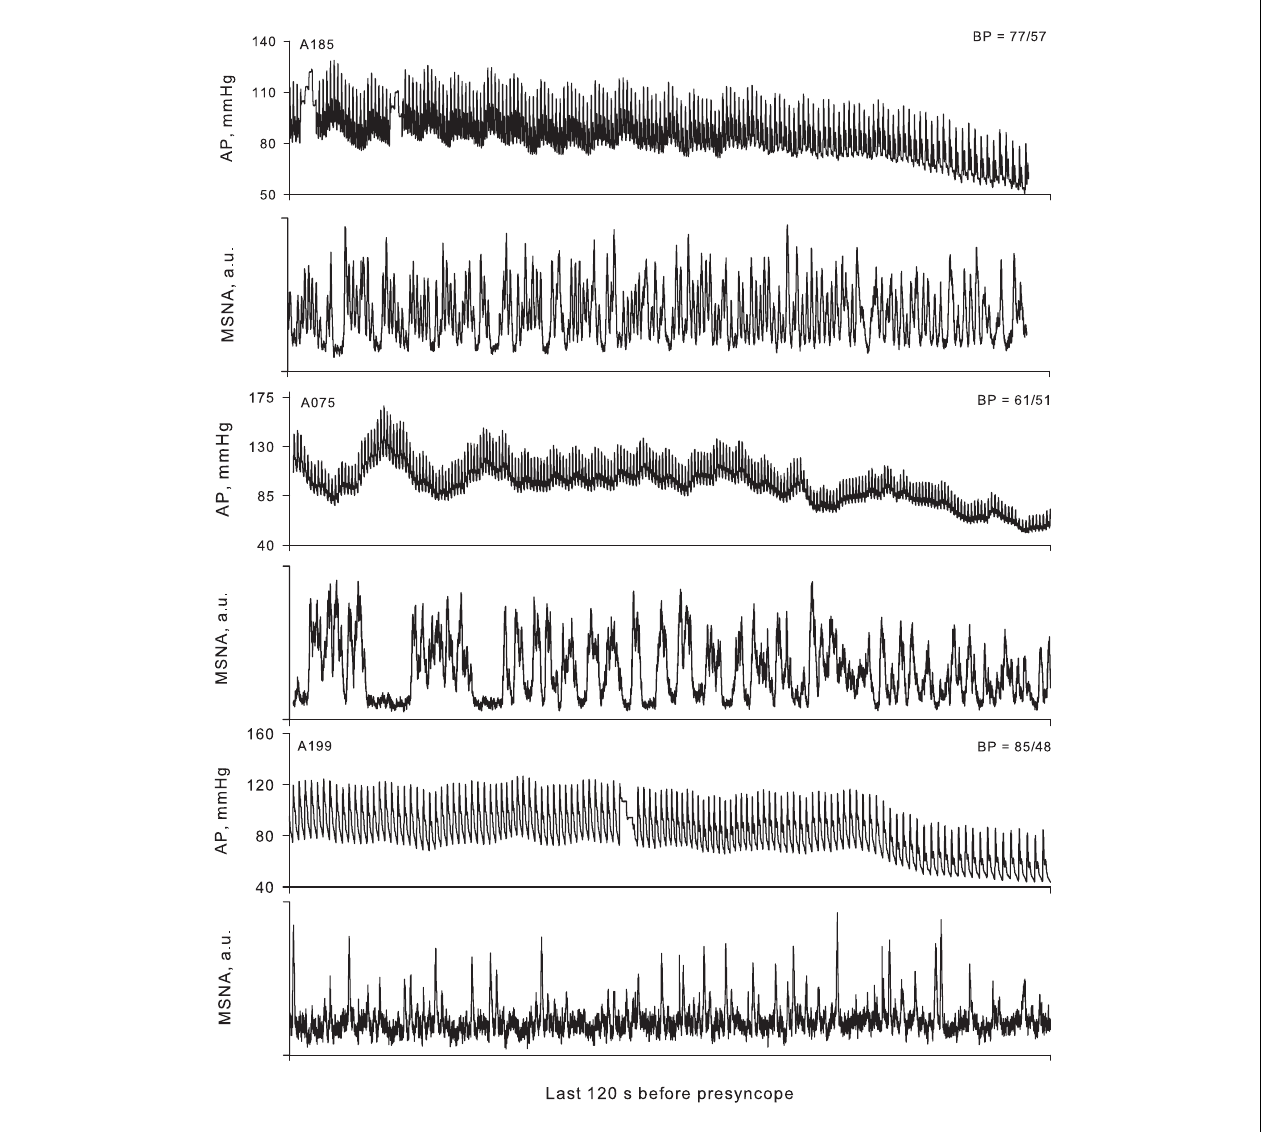
FIGURE 5 |Arterial pressure (AP) and muscle sympathetic nerve activity (MSNA) for three representative subjects 2min before the onset of presyncope. The lowest arterial pressure (BP) recorded for each subject is shown in the upper right corner of each AP panel. In subject A185, MSNA decreased in the last 2min of LBNP ( − 120 to − 60s, 82bursts/min; − 60s to presyncope, 64bursts/min), but was still maintained at high levels relative to the pre-LBNP control